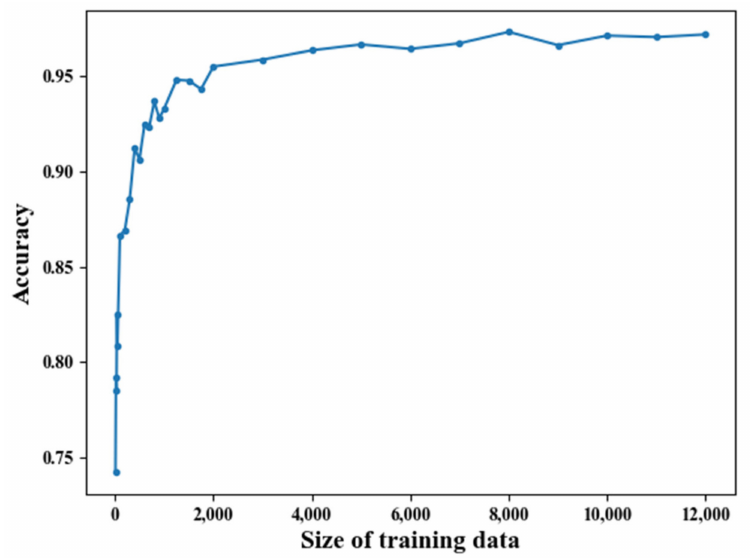
Figure 5. Accuracy of a classifier by the size of training